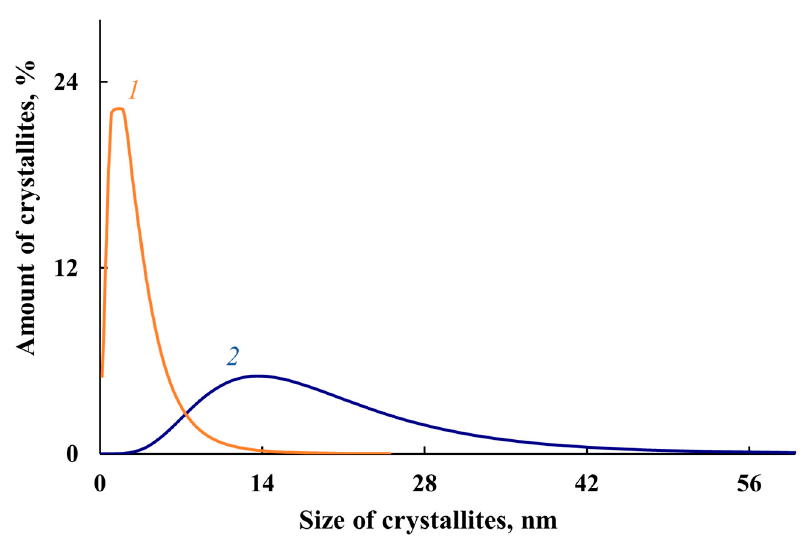
Figure 9. Crystallites size distribution in Fe 3 O 4 /P ‐ N ‐ PAA ( 1 ) and MNP/P ‐ N ‐ PAA ( 2 ).